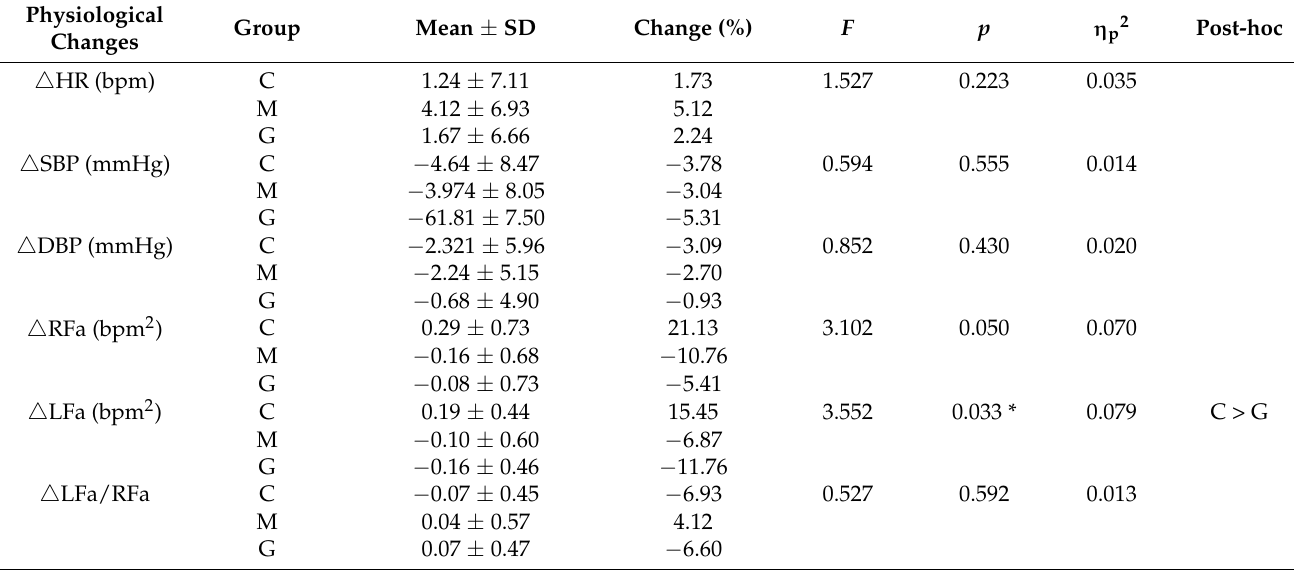
Table 6. Comparisons of physiological response changes among the three